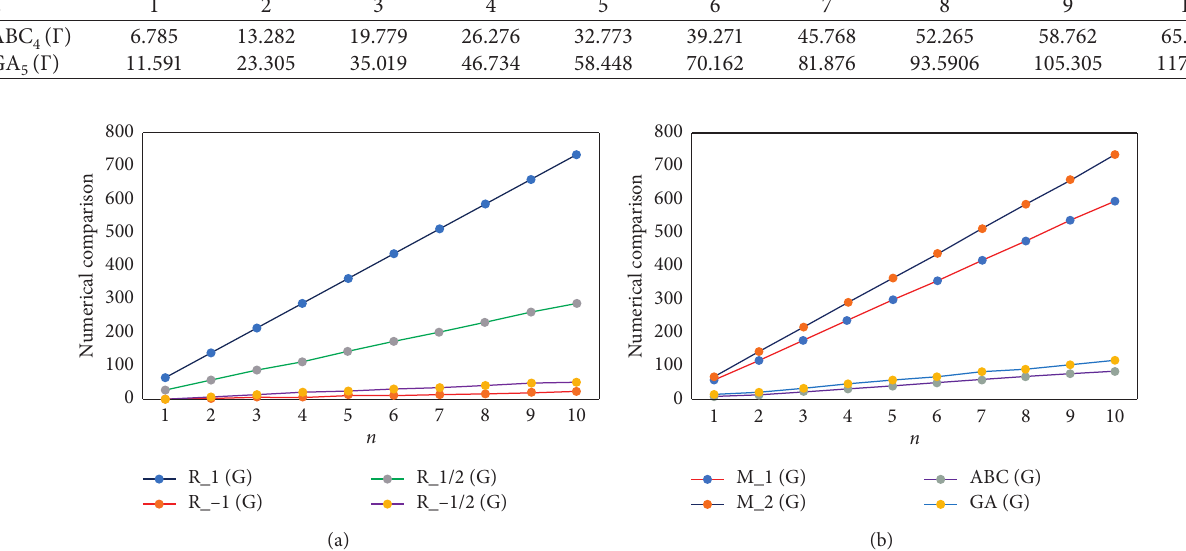
Figure 3: (a) Comparison of R